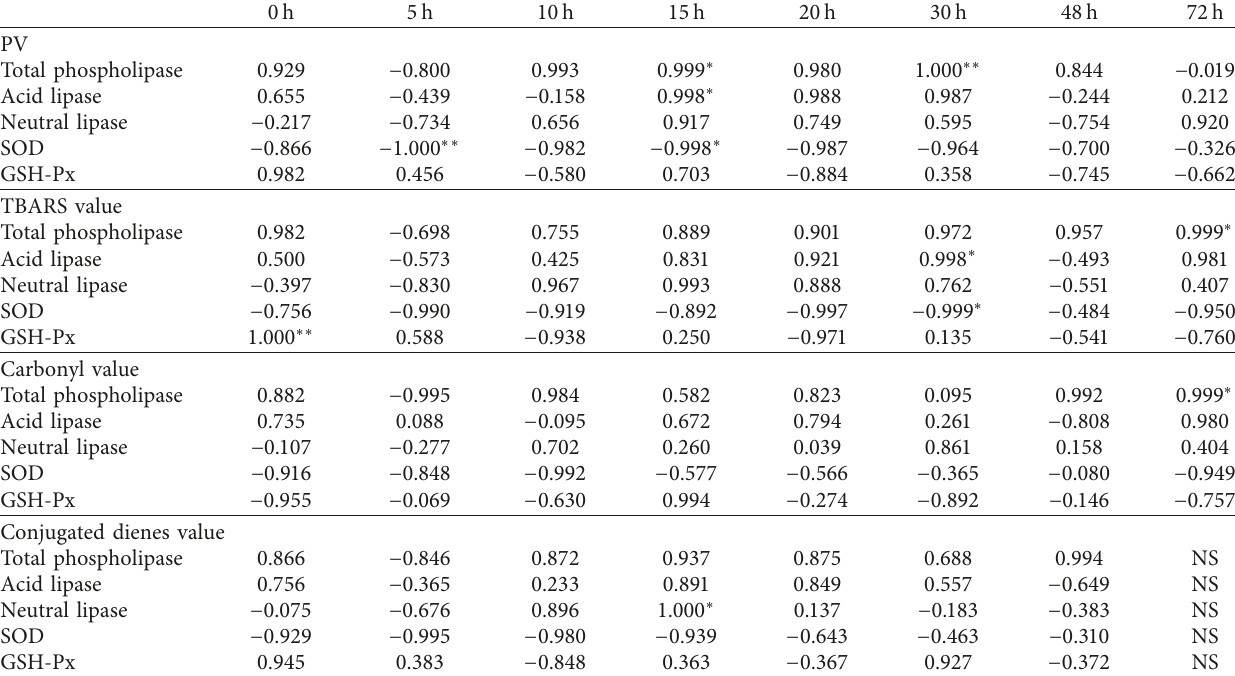
Table 4: Correlation of oxidation indices and total phospholipase, acid lipase, neutral lipase, and SOD and GSH-Px activities with different additions of